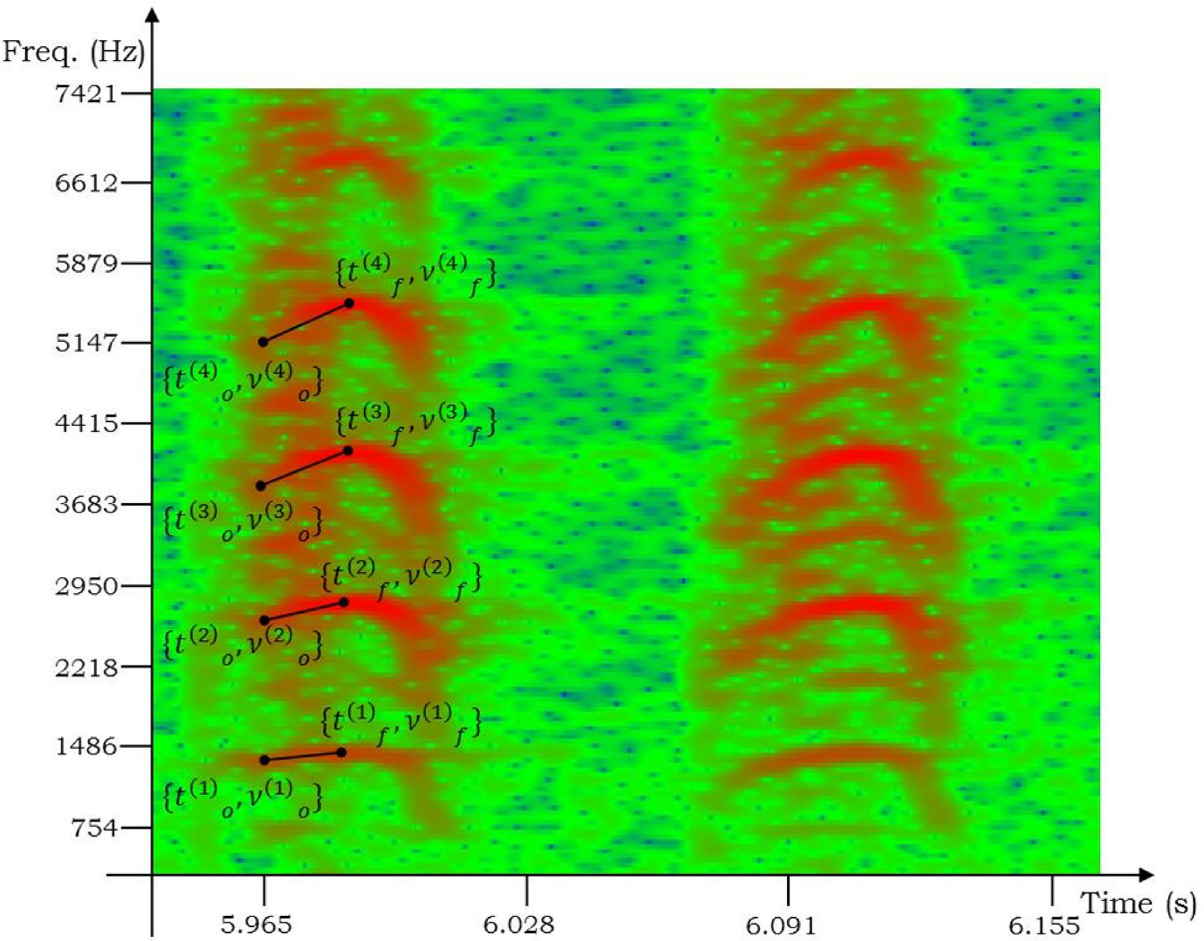
Figure 3. Two klee notes from a recording of the F. femoralis (aplomado falcon). Several harmonics are visible (red) for each. The initial time t within each harmonic n are labeled for the first